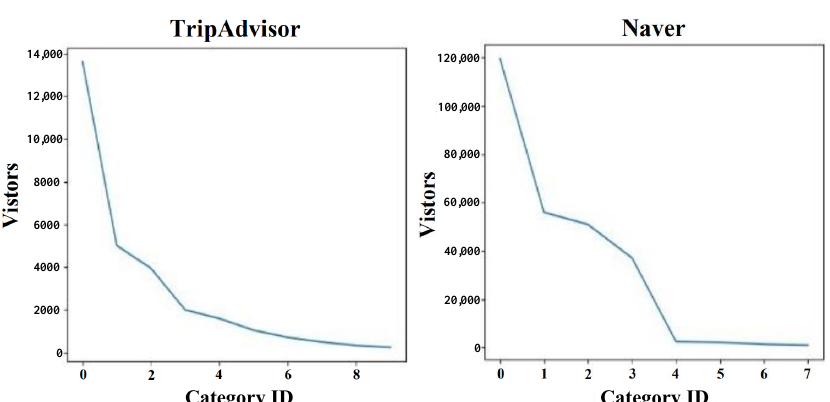
Figure 4. The number of visitors for each POI.